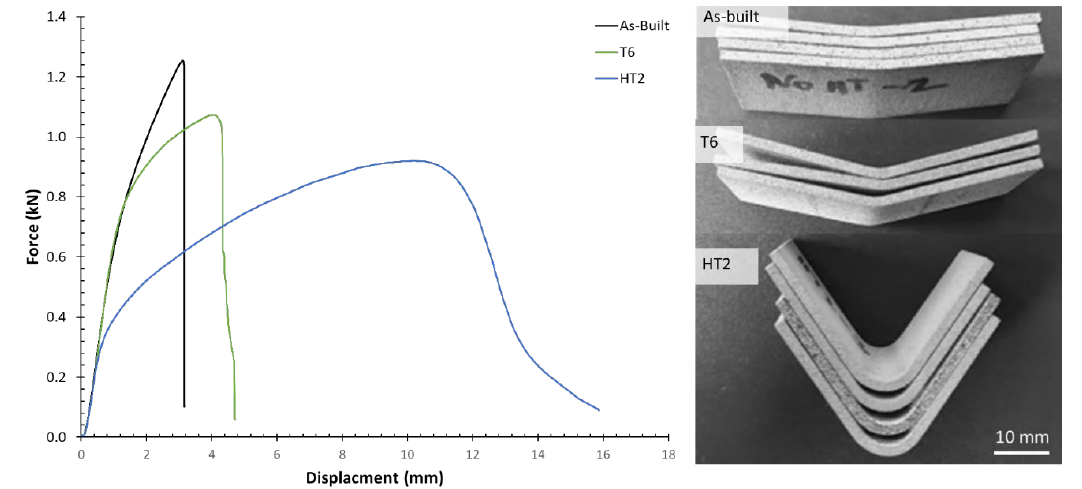
Figure 7. Force–displacement curves of the 3-point bending tests of as-built, T6 and HT2. The respective samples are shown on the right.